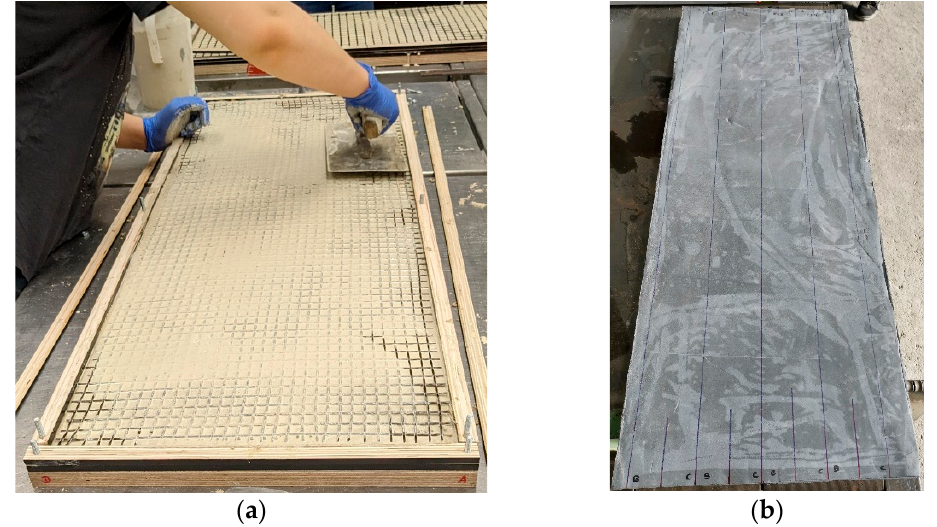
Figure 7. Sample preparation. ( a ) Lamination process; ( b ) TRM plate (1100 mm × 400 mm × 20 mm) before cutting